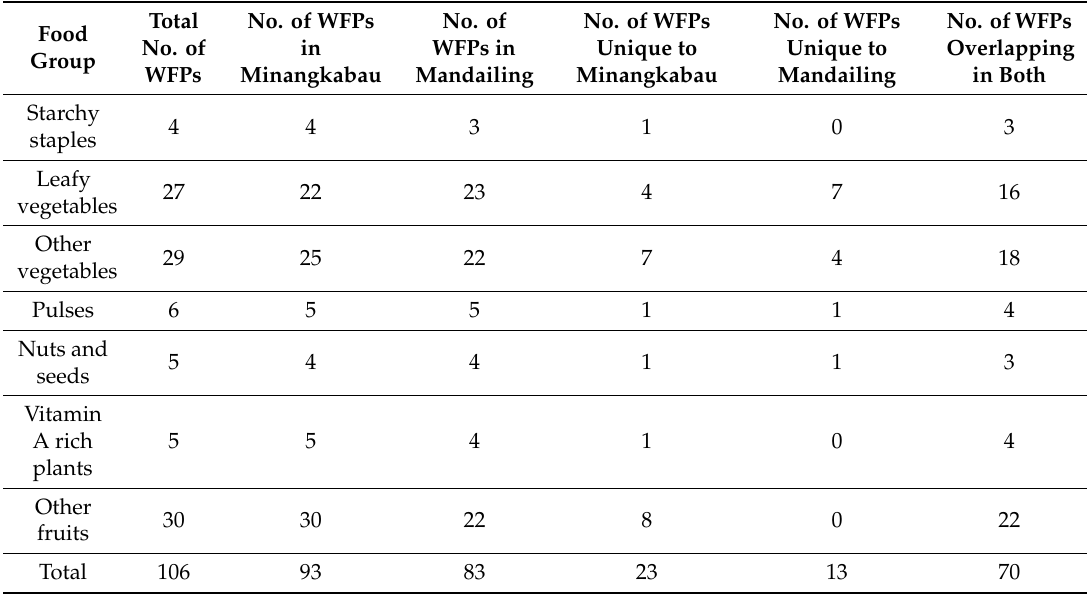
Table 1. Comparison of wild food plant diversity between Minangkabau and Mandailing ethnic